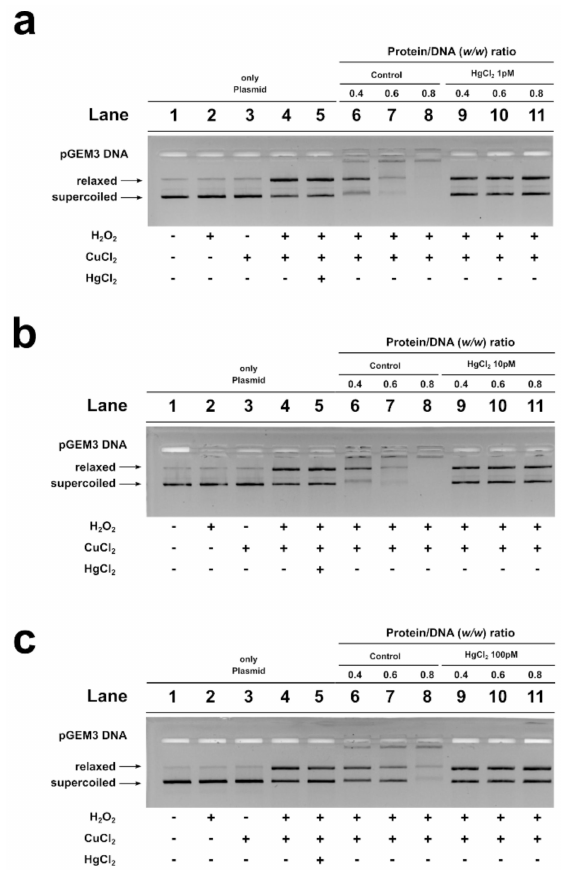
Figure 5. DNA protection analysis on 1% agarose gel of pGEM3 plasmid DNA in the presence of increasing (0.4, 0.6, and 0.8) PL/DNA ratios. Control (lanes 6, 7, and 8 of all the panels); 1 pM HgCl 2 (lanes 9, 10, and 11 of panel ( a )); 10 pM HgCl 2 (lanes 9, 10, and 11 of panel ( b )); 100 pM HgCl 2 (lanes 9, 10, and 11 of panel ( c